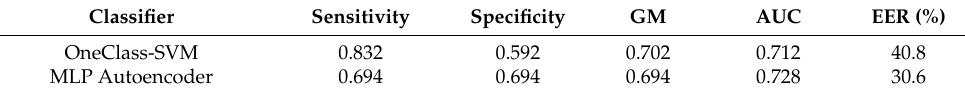
Table 5. LOSO evaluation results of the novelty detection models. 64-bin FFT and overlap 75%.